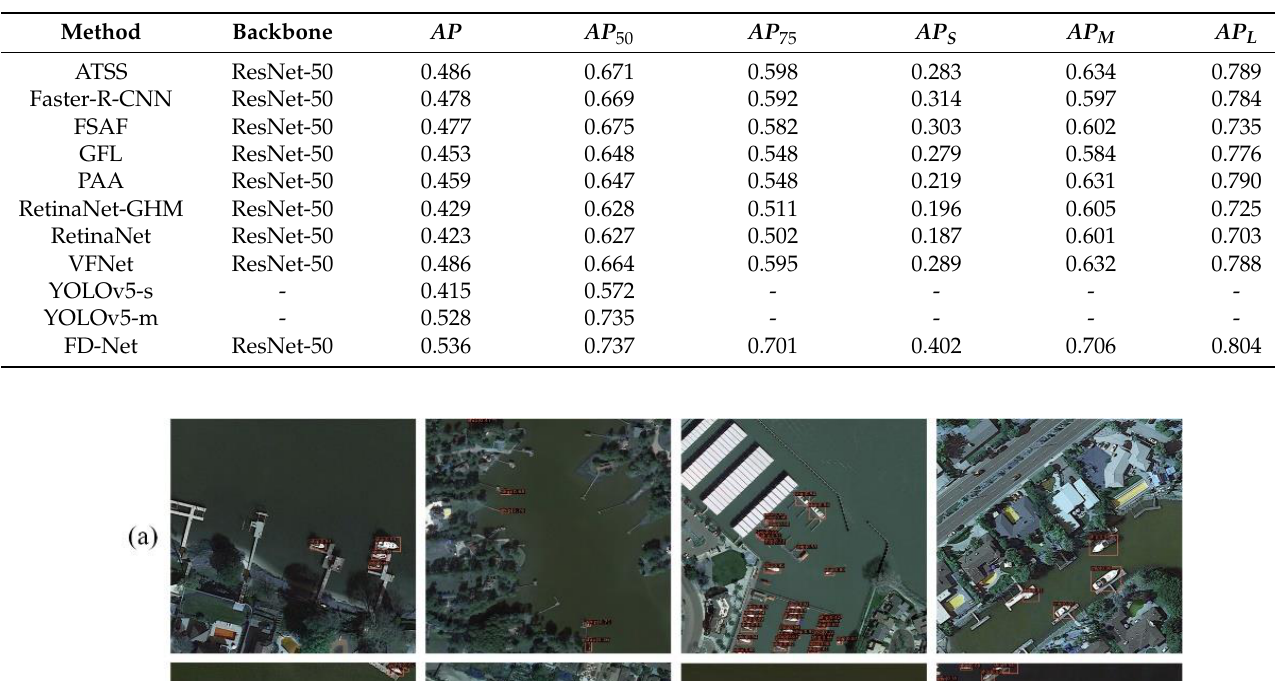
Table 3. Performance evaluation of different methods on the DOTA v1.5 dataset.